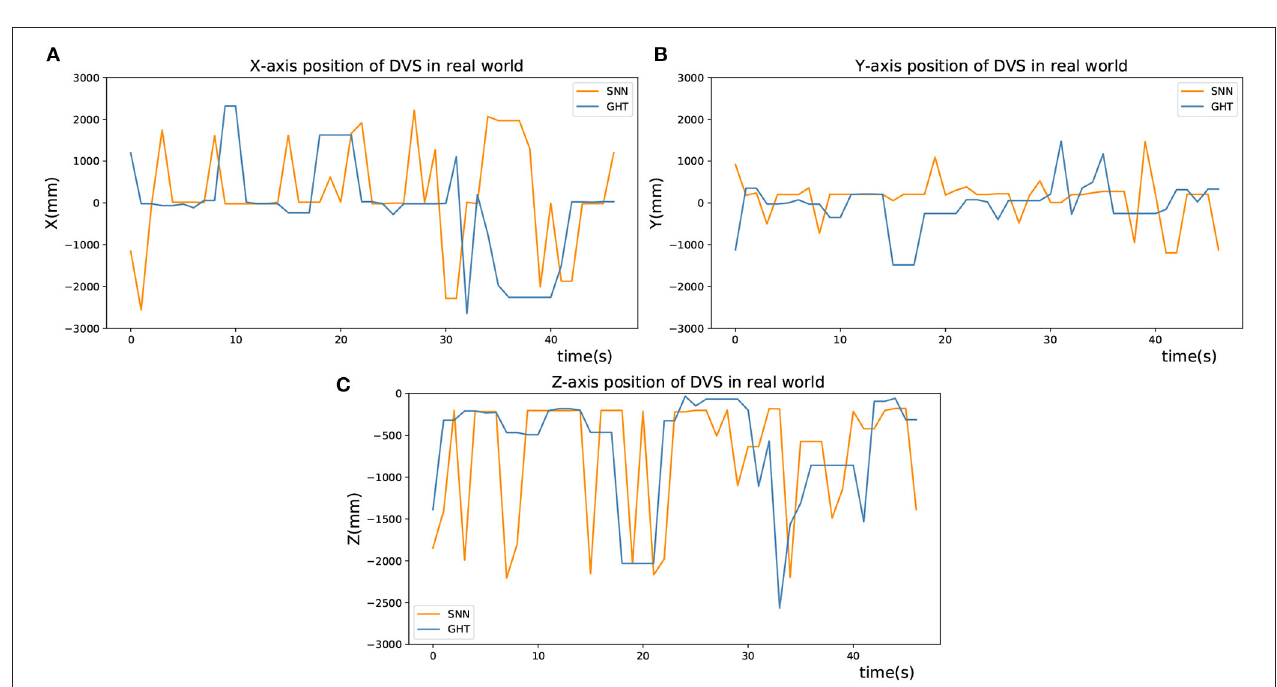
FIGURE 11 | Position estimation in real world. (A) X-axis position of DVS in real world. (B) Y-axis position of DVS in real world. (C) Z-axis position of DVS in real world.